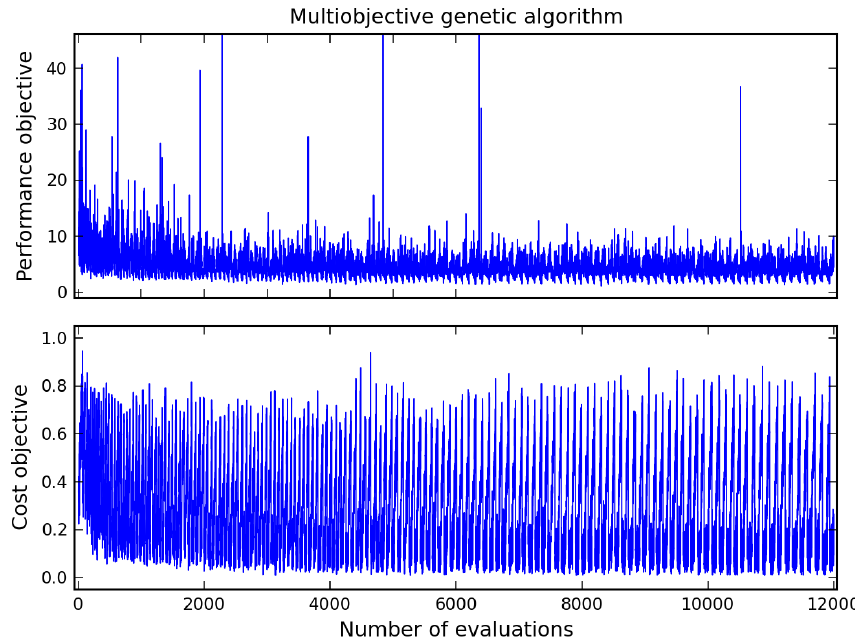
Figure 7. The figure displays the raw objective function evaluations during the evolution of a population of network designs using MOGA to optimize performance (upper panel) and cost (lower panel).